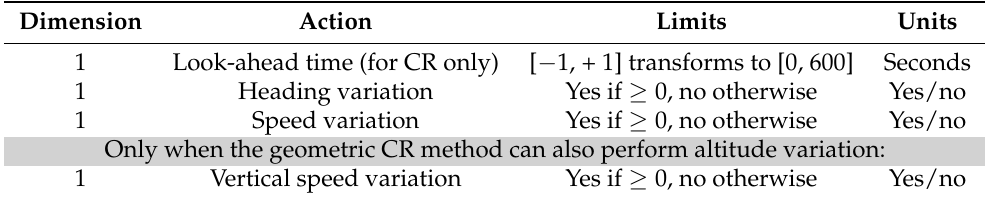
Table 3. Action formulation of the RL method.